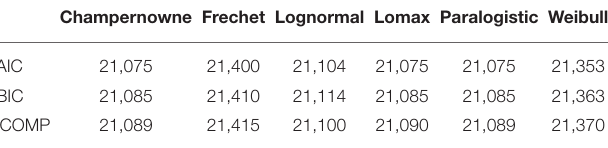
TABLE 8 | Simulation: Information criteria for Champernowne, Frechet, Lognormal, Lomax, Paralogistic, and Weibull models. Champernowne Frechet Lognormal Lomax Paralogistic Weibull